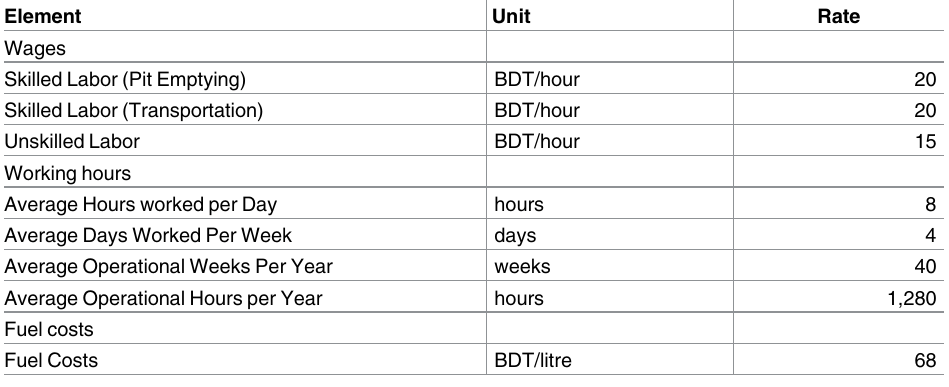
Table 3. Unit costs and working hours. Element